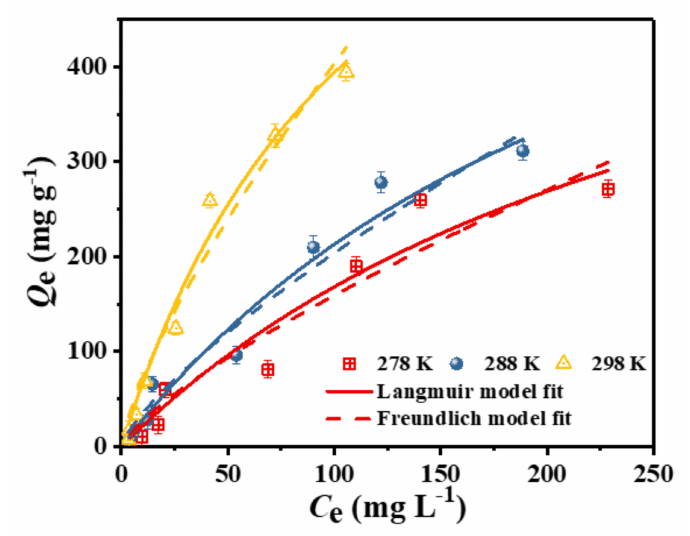
Figure 8. Adsorption isotherms of 3,4,5-TCP adsorption onto the C-O/W microcapsules and non- linear fitting curves according to the Langmuir and Freundlich equations (pH = 5.0, T = 278 K, 288 K, 298 K).